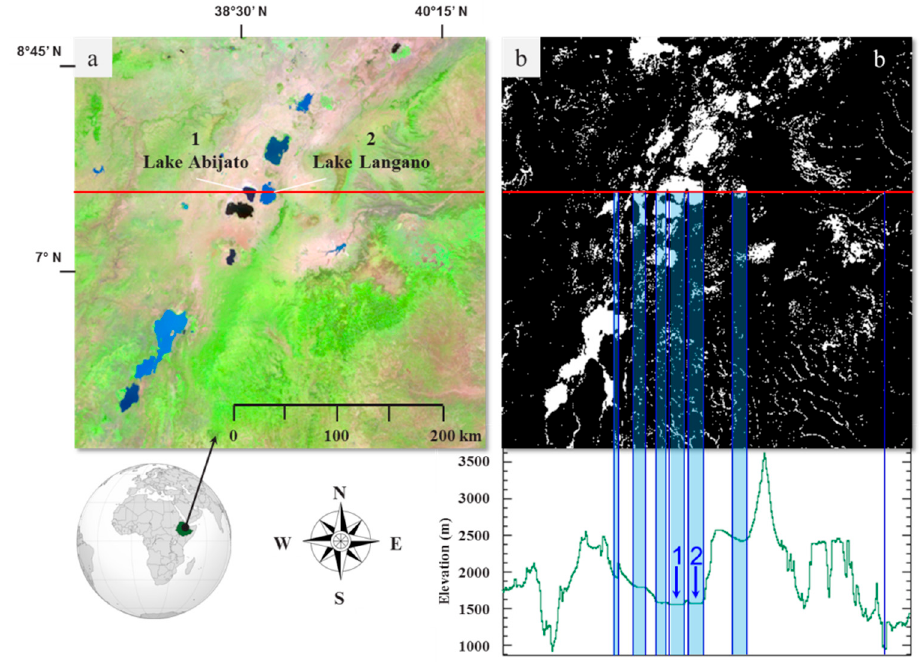
Figure 3. ( a ) PROBA-V mean composite for the dekad 21 October 2013 taken over the Rift Valley in Ethiopia (SWIR, NIR and Red bands assigned to the Red, Green and Blue (RGB) channels, respectively). Some of the larger lakes can be easily recognized. ( b ) The Water Body Probability Mask for the same area. The white pixels indicate locations of potential water bodies. The plot shows the vertical profile according to the red line. Marked with the blue boxes are the seven larger potential water bodies. The arrows indicate the location of: Lake Abijato (1); and Lake Langano (2).